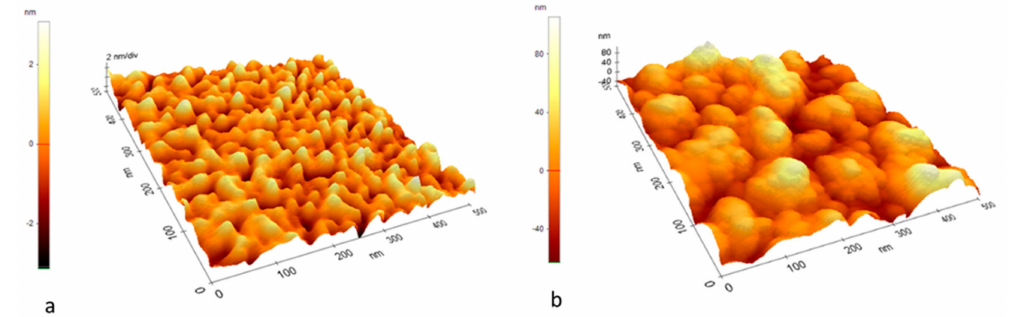
Figure 5. AFM image of the AChE enzyme on the S2 ( a ) and S3 ( b ) sensor surface. The roughness per area measured 500 nm × 500 nm is 1.1 nm and 37 nm, respectively.